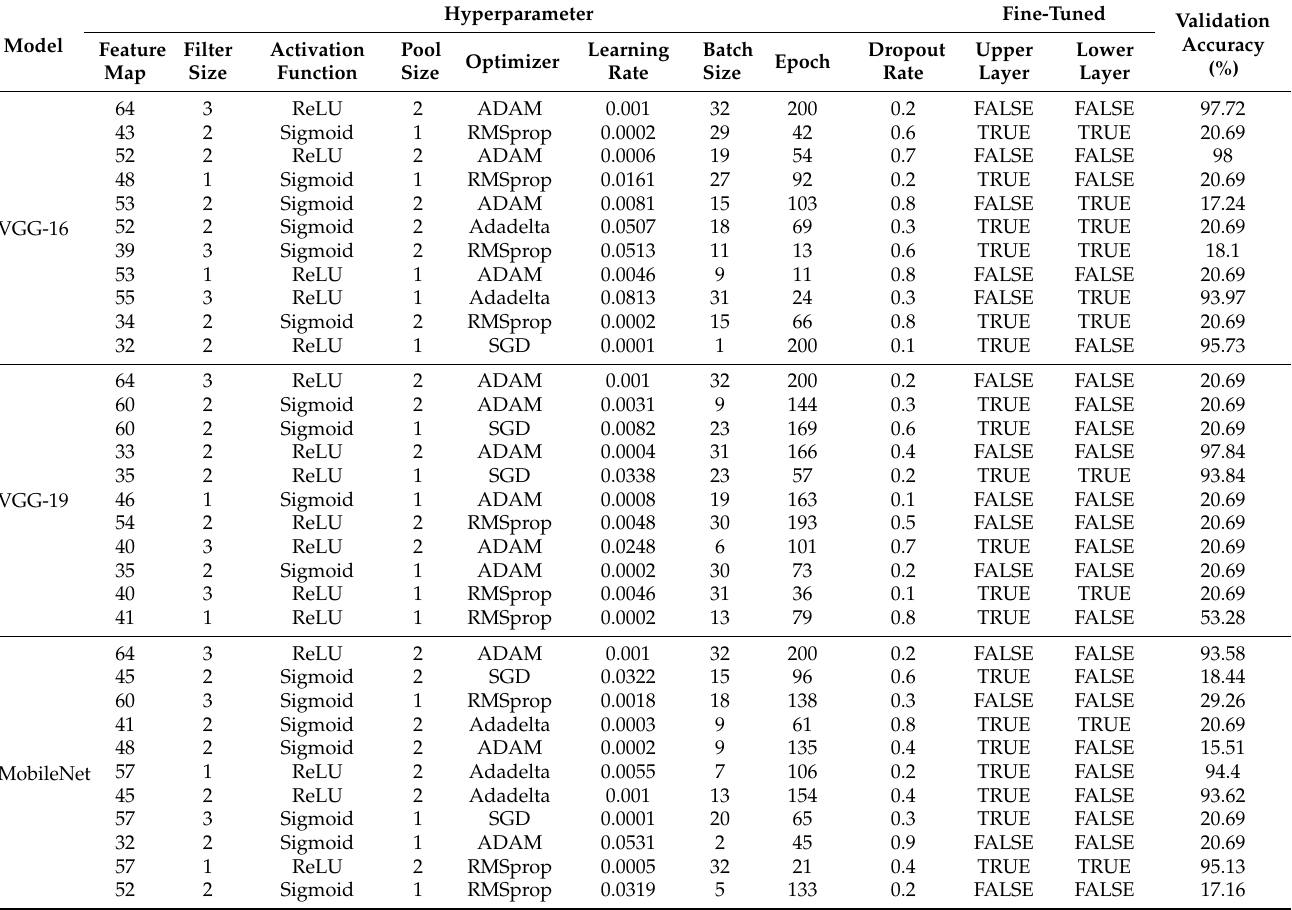
Table 4. Validation of automated hyperparameter tuning and automated fine-tuning of each pre- trained